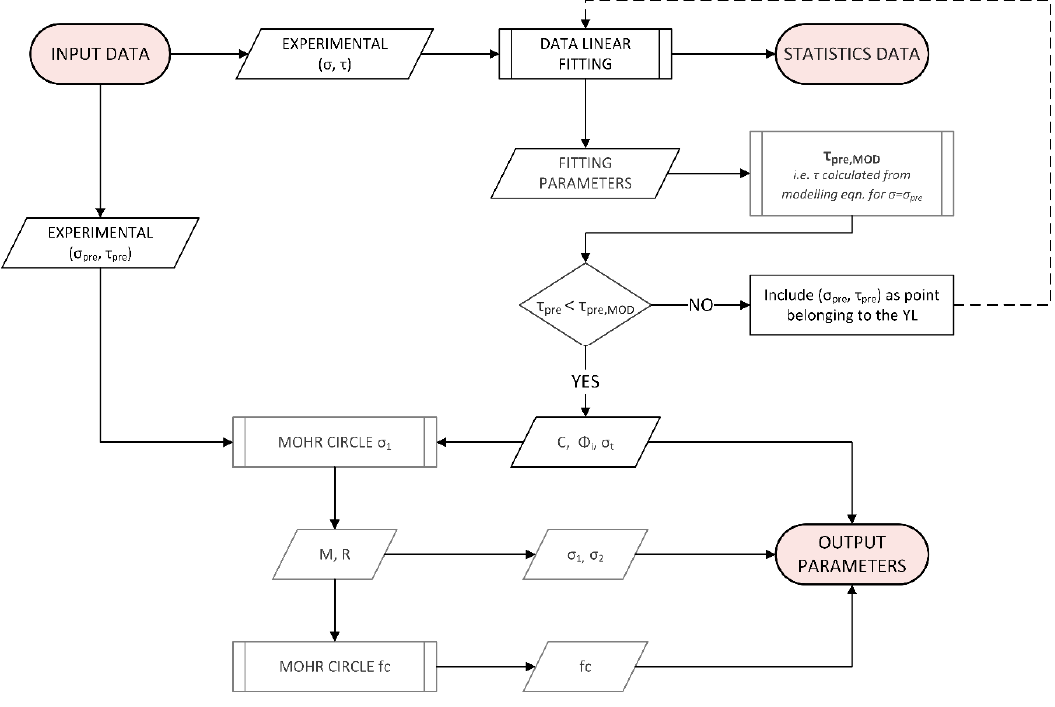
Figure 5. Linear YL sub ‐ process structure.